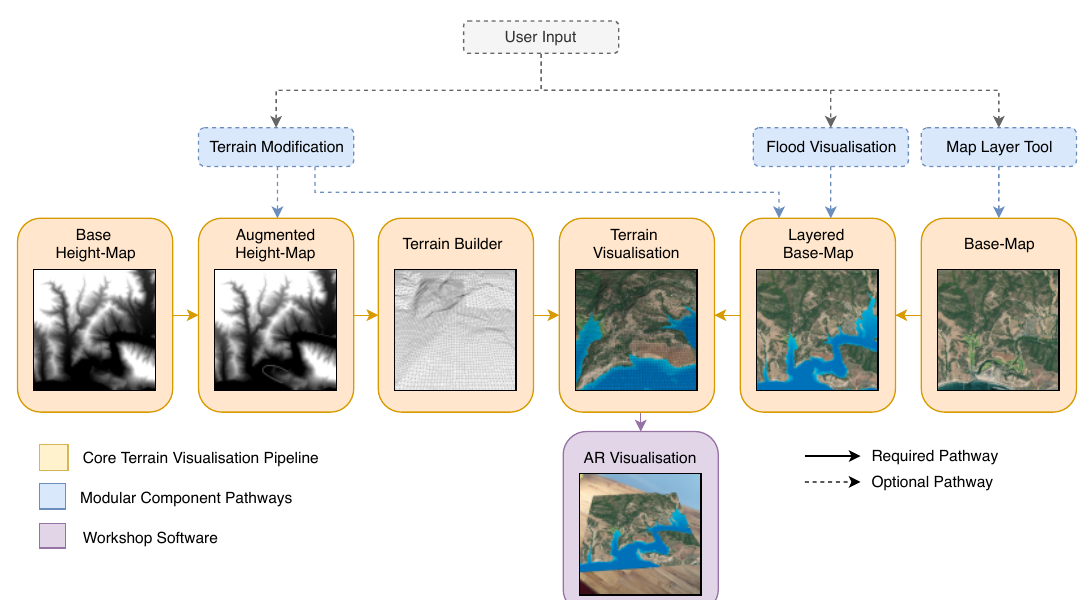
Figure 1. The Terrain Visualisation pipeline. Yellow boxes show the main pipeline, with points of optional expansion for additional components shown in blue.